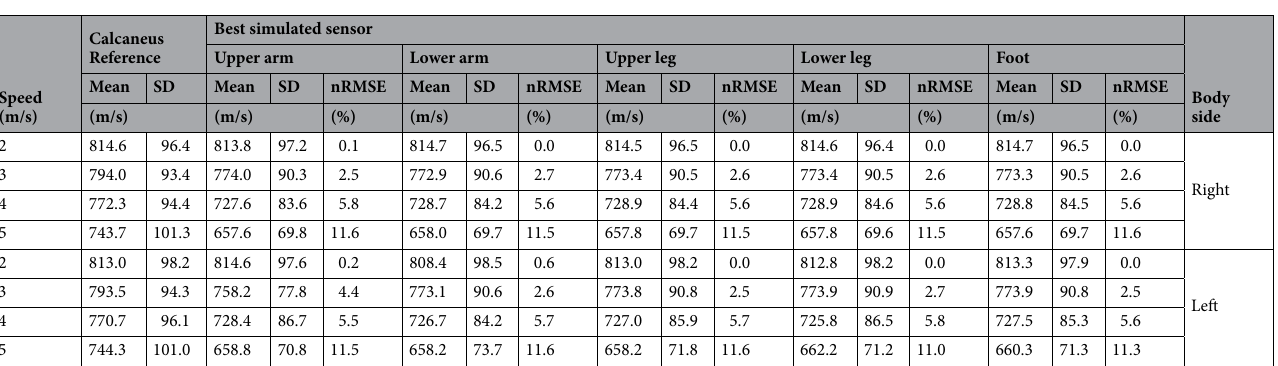
To further illustrate the effect of sensor position variation on estimated stride duration, we derived stride distance errors of the best sensors. Average distance errors at 5 m/s were 4.88 ± 1.53 cm for the upper arm, and below 5.52 ± 1.53 cm at the lower arm, upper leg, lower leg, and foot at both body sides. Below 5 m/s, errors decrease to below 3.36 ± 0.27 cm at 4 m/s, below 2.81 ± 0.21 cm at 3 m/s, and below 1.64 ± 0.13 cm at 2 m/s at both body sides.